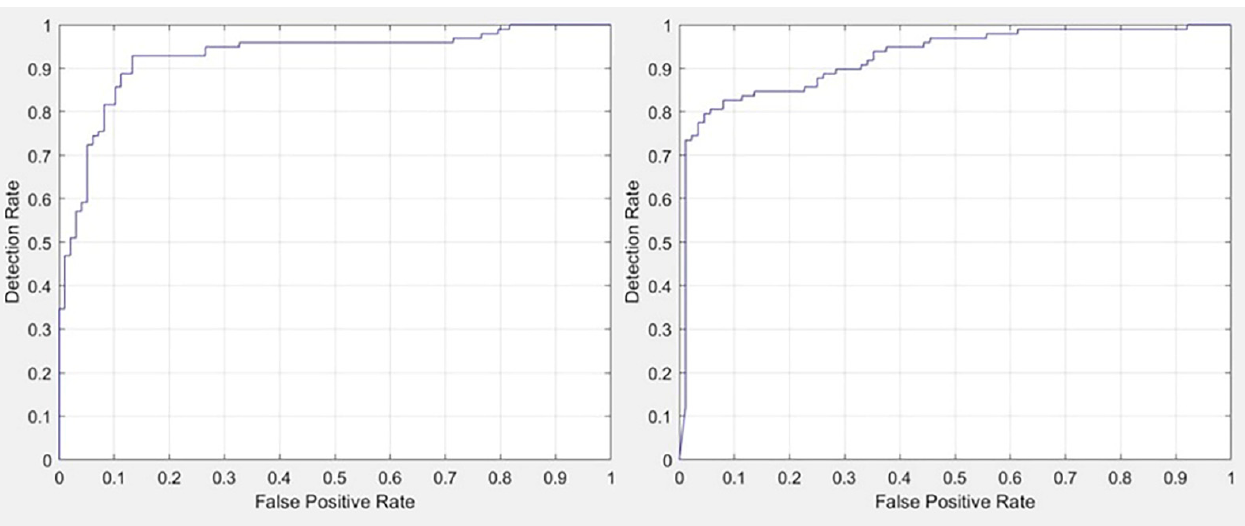
Figure 2. ( Left ) areas under the curve at receiver operating characteristic analysis for COVID-19 versus negative and ( Right ) for COVID-19 versus community-acquired pneumonia in the cross-validation phase.